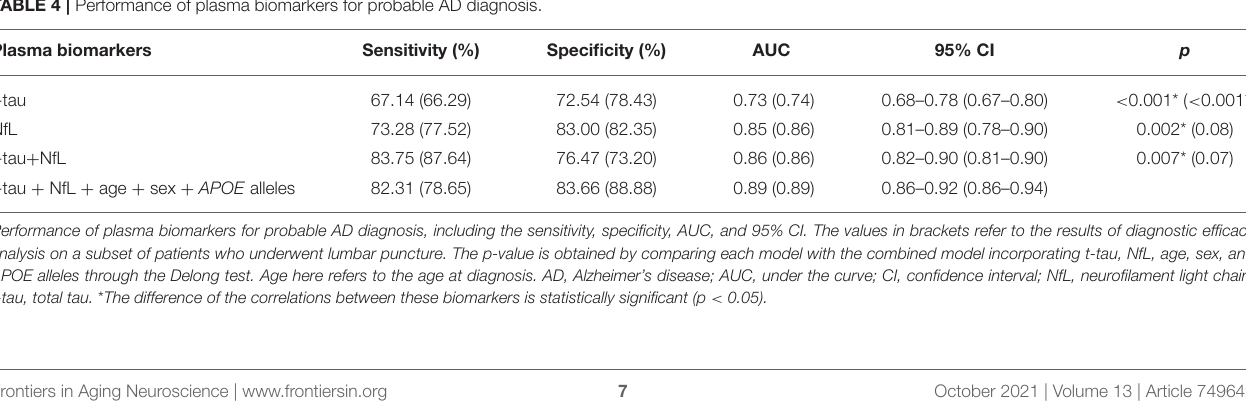
Frontiers in Aging Neuroscience |